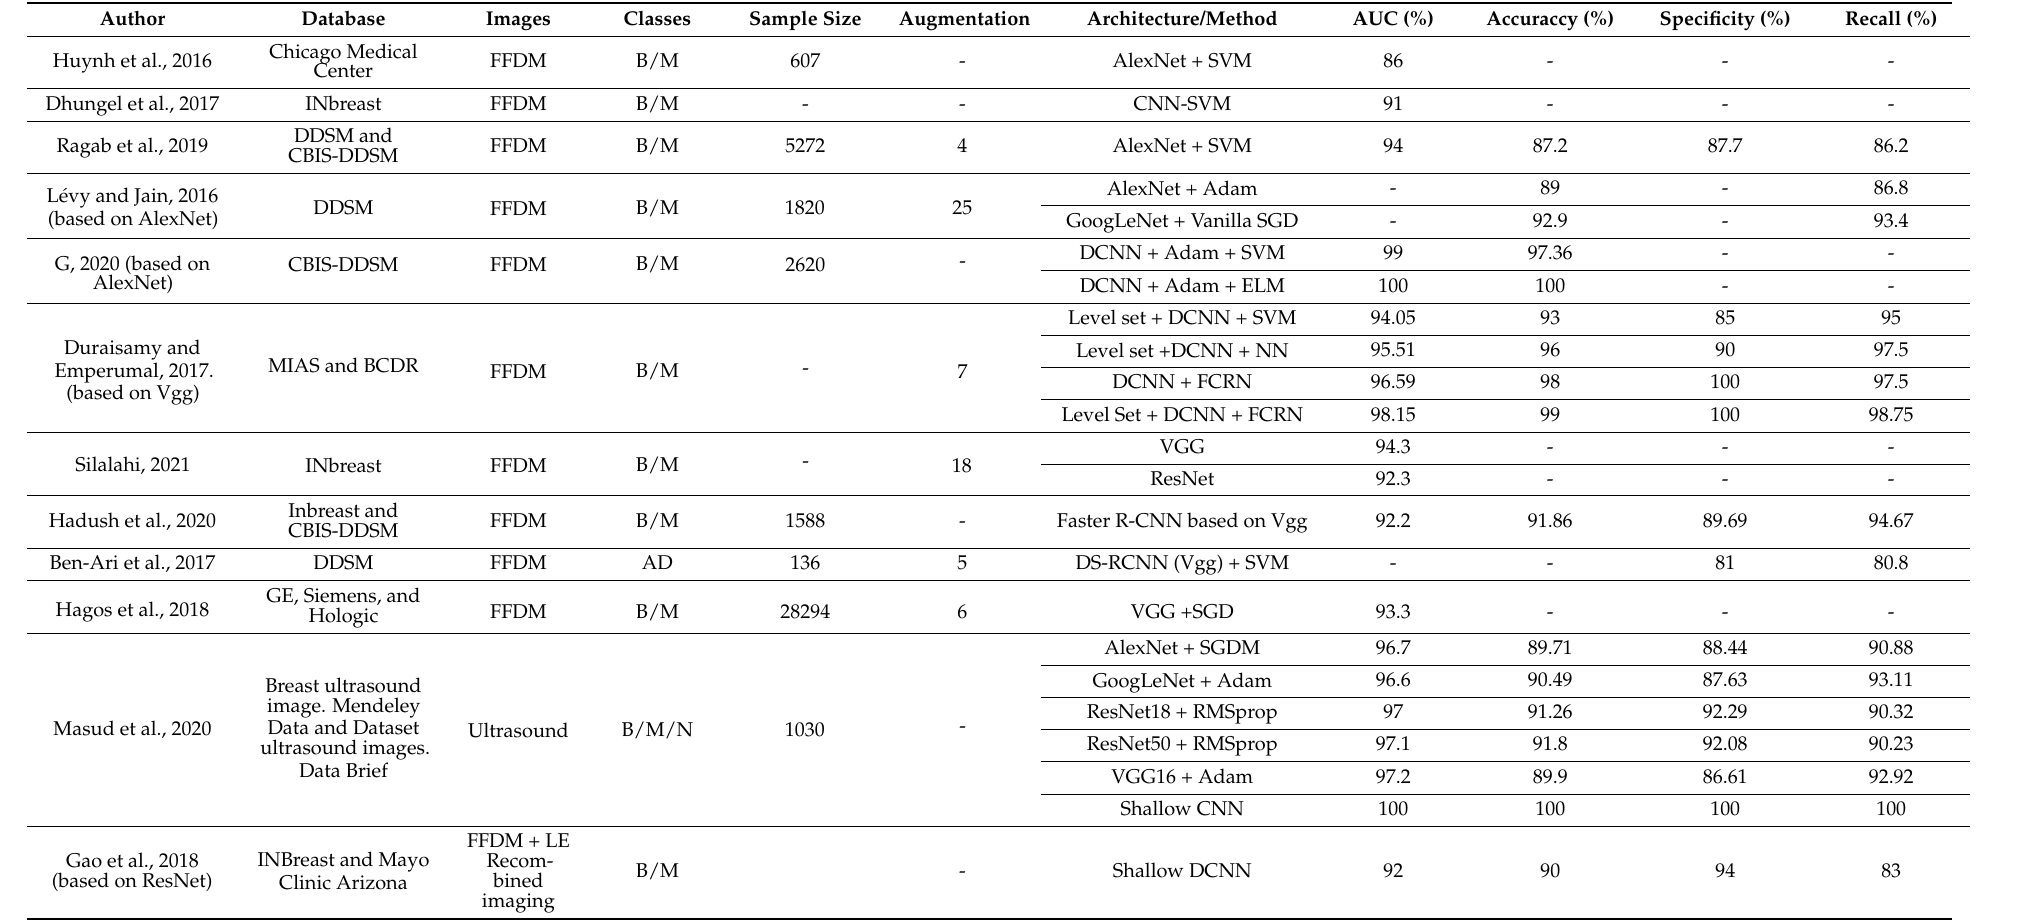
Table 1. Summary of techniques and performance between models for cancer